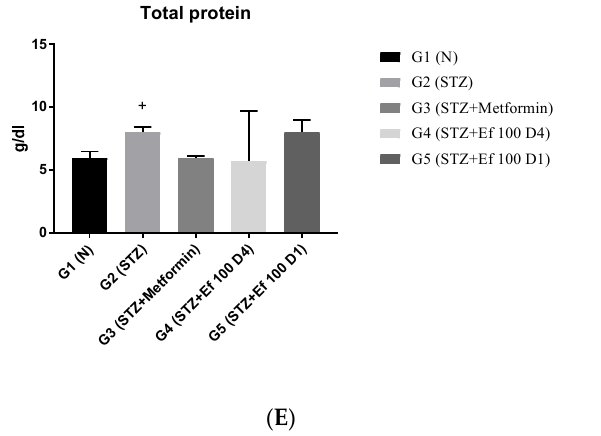
Figure 5. Effects of different treatments on serum markers of the liver in different experimental groups. On Day 30, the concentrations of ALT ( A ), AST ( B ), ALP ( C ), total bilirubin ( D ), and total protein ( E ) were measured in all the groups. Bars represent the mean of the parameters ± SD of 6 rats. The concentrations of ALT, AST, and ALP were significantly (*** p < 0.0001) decreased in induced diabetic rats treated with metformin (G3) and Ephedra foeminea extract (G4 and G5) compared to the untreated induced diabetic rats (G2). Concentrations of total bilirubin and total proteins did not differ significantly compared to the untreated induced diabetic rats (G2). The results are expressed as means ± SD ( n = 3–4 dependent replicates), ***: p < 0.001 compared to G2: diabetic rats. +: p < 0.05, +++: p < 0.001 compared G1: nondiabetic rats. The result were analyzed using one way